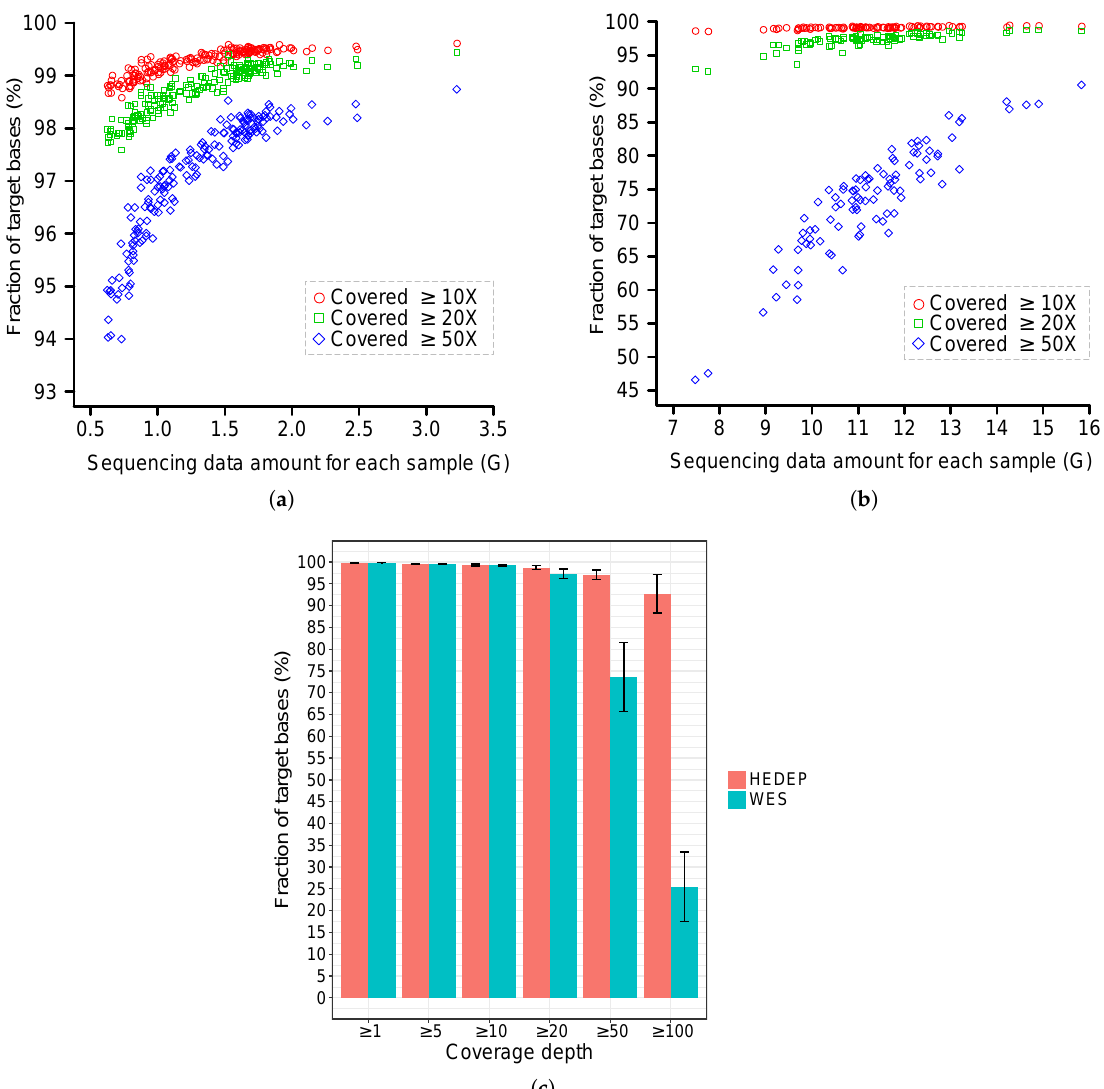
Figure 2. Coverage analysis for hereditary eye disease enrichment panel (HEDEP) and whole exome sequencing (WES). ( a ) The x -axis indicates the amount of clean data (after removing low quality reads from raw sequencing results) for each sample subjected to HEDEP. The y -axis indicates the fraction of target base pairs that had at least 10 × , 20 × , and 50 × coverage for each sample, respectively. ( b ) The x -axis indicates the amount of clean data for each sample subjected to WES. The y -axis indicates the fraction of target base pairs (exonic regions for 441 hereditary eye disease genes) that had at least 10 × , 20 × , and 50 × coverage for each sample, respectively. ( c ) Sequencing coverage comparison of HEDEP and WES. Bar plots show the fraction of target base pairs (exonic regions for 441 hereditary eye disease genes) that were covered to at least the depth indicated on the x -axis. Error bars indicate standard